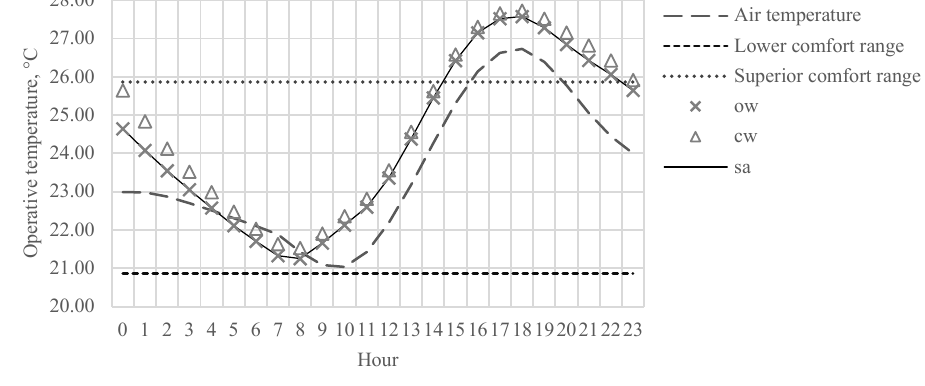
Fig. 6. Operative temperature analysis for March 16.